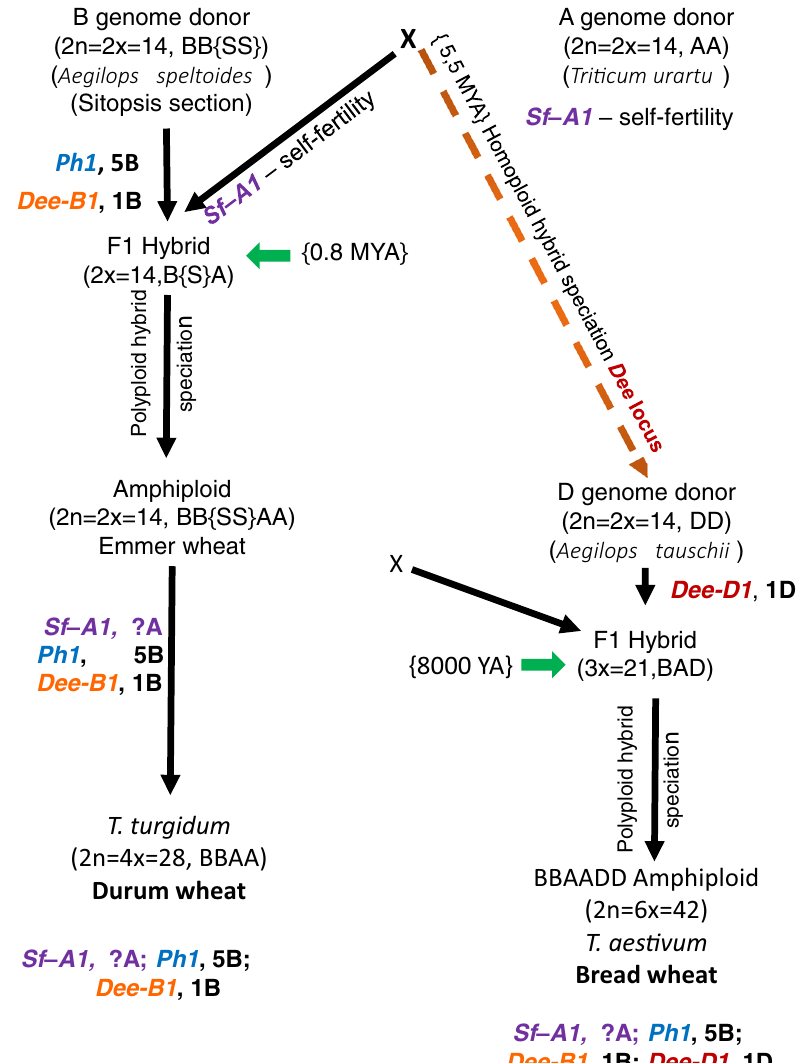
Fig. 6 Putative involvement of Dee-D1 in hybridization events. Dee-D1 leads to the evolution of tetraploid and hexaploid wheat, the evolution model based on Mujeeb-Kazi et al. 48 and Rasheed et al. 30